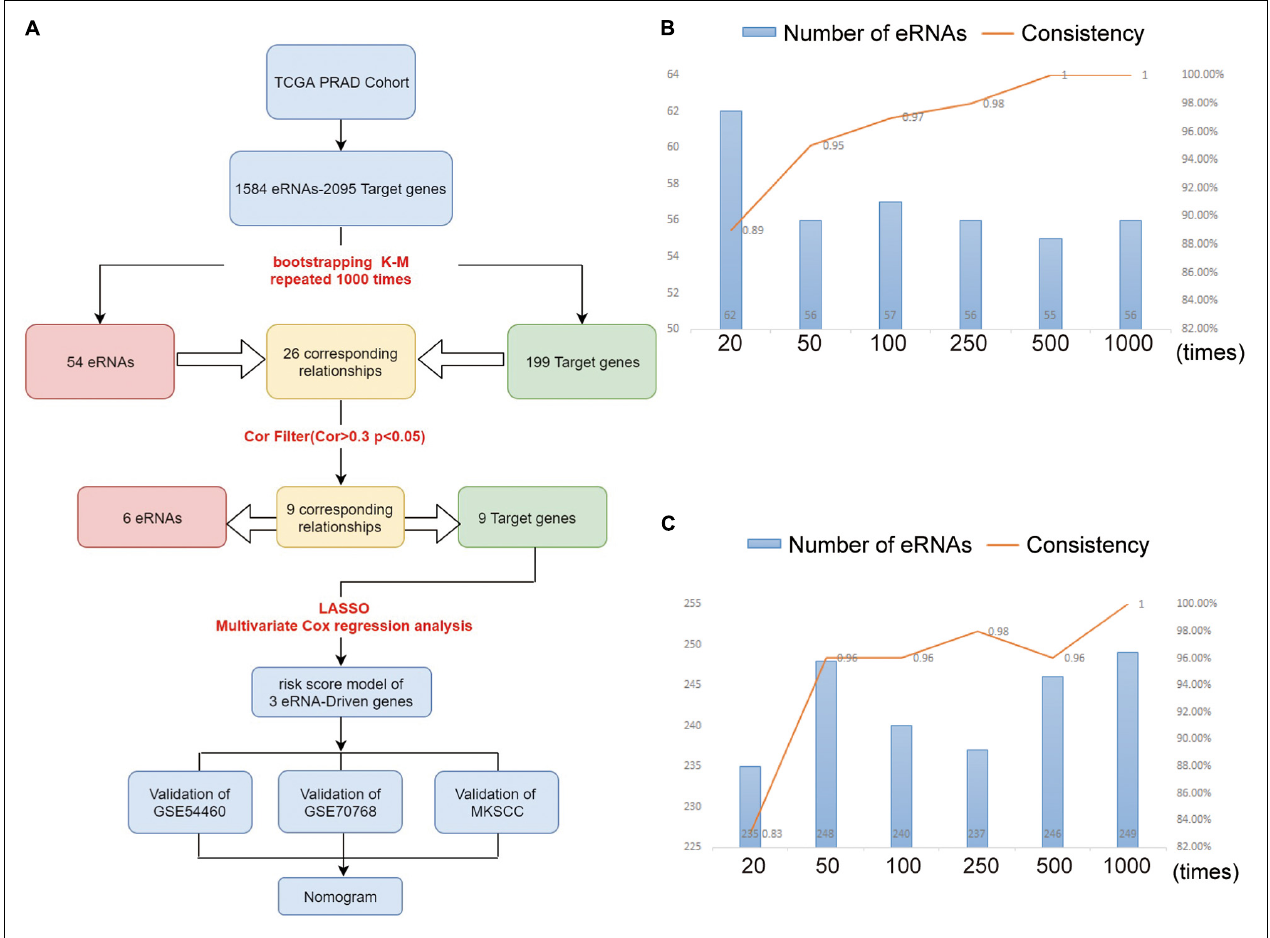
FIGURE 1 | (A) The workflow of the study. The eRNAs (B) and target genes (C) results of nodes 10, 40, 90, 240, 490, 990 compared with nodes 20, 50, 100, 250, 500, and 1,000. As the number of repetitions increased, we compared the results at the node with the previous 10 times, and found that the consistency of the results increased continuously. At the level of 1,000 repetitions, the consistency reached about